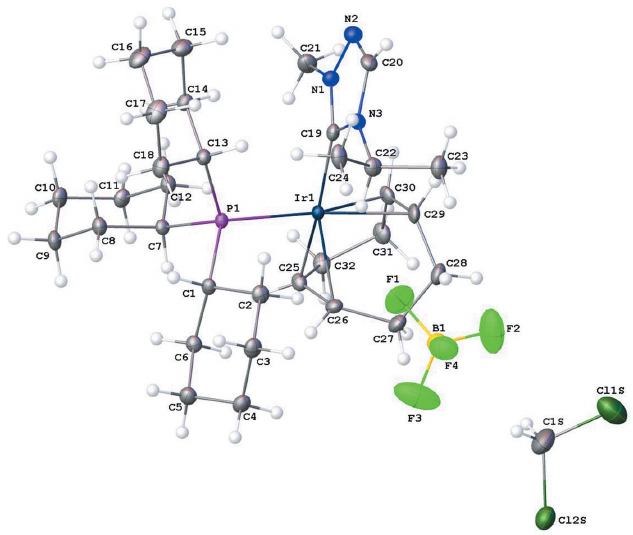
Figure 1 The molecular entities in the crystal structure of the title compound ( 4 ). Displacement ellipsoids are drawn at the 50% probability